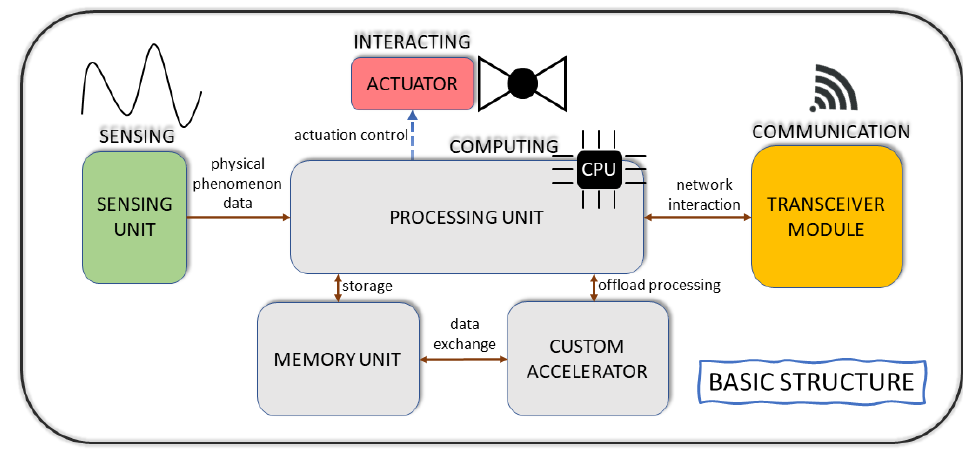
Figure 2. Basic structure of a sensor node (adapted from